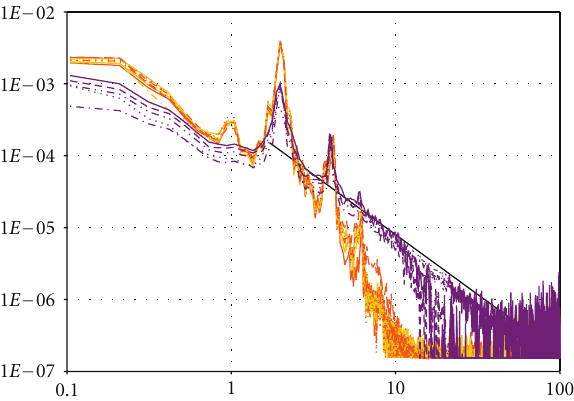
Figure 13: Energy spectrum of the vertical velocity fluctuations in the forced vortex ( z ∗ = 0 . 11 and r ∗ = 0 . 18). Violet line: experiments (measured at 0, 90, 180, and 270 ◦ at the same z ∗ and r ∗ ); orange lines: LES computations (measured at 0, 45, 90, ... , 315 ◦ ) at the same z ∗ and r ∗ ). The black straight line is a k − 5 / 3 slope.